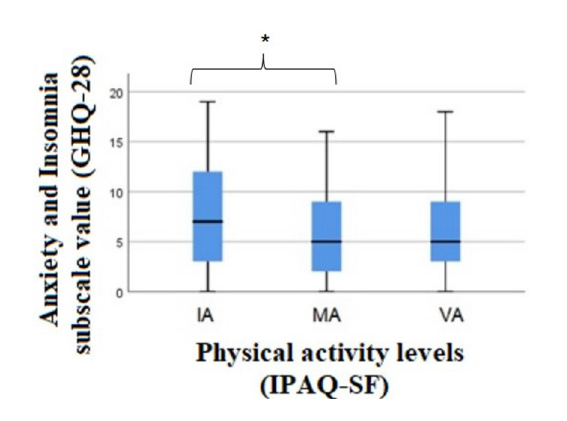
FIGURE2 Results of the Kruskal-wallis test for the comparison of anxiety and insomnia between the levels of physical activity. GHQ-28, General Health Questionnaire-28; AI, Insufficiently Active; MA, Moderately Active; VA, Vigorously Active; PA, Physical Activity; IPAQ-SF, International Physical Activity Questionnaire; *Significant differences between the category IA and MA individuals ( p = 0.005).